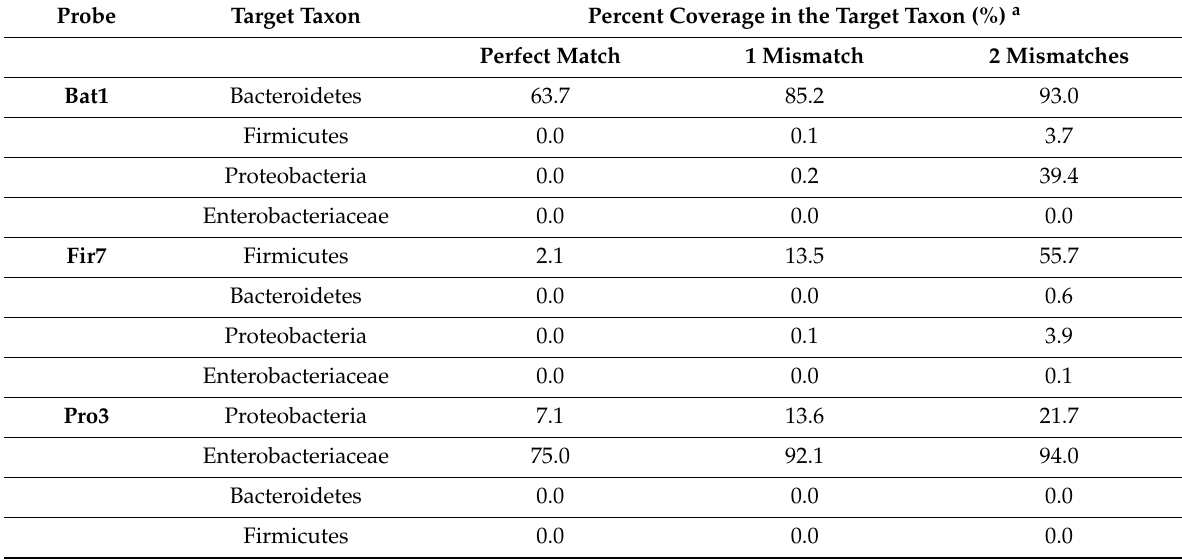
Table 2. In silico PCR assay with newly designed